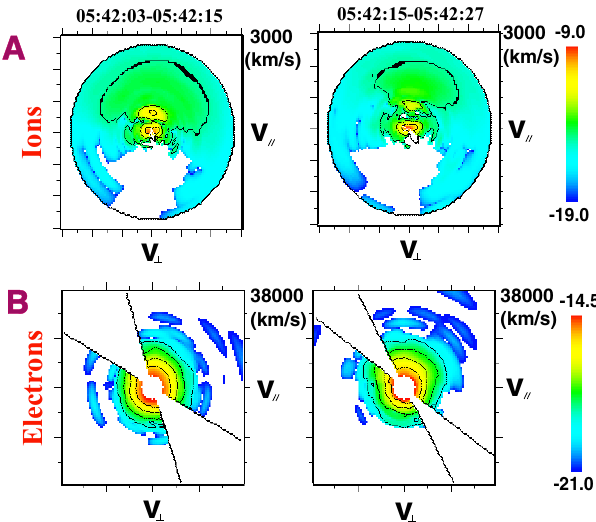
Plate 2. Distribution functions of ions (Panel A) and electrons (Panel B) for the case of the acceleration of multiple-beams parallel to the magnetic field. The distribution functions are the slices of the 3-dimensional distribution functions in the velocity plane including the magnetic field B ( V k ) and the E × B drift vector ( V ⊥